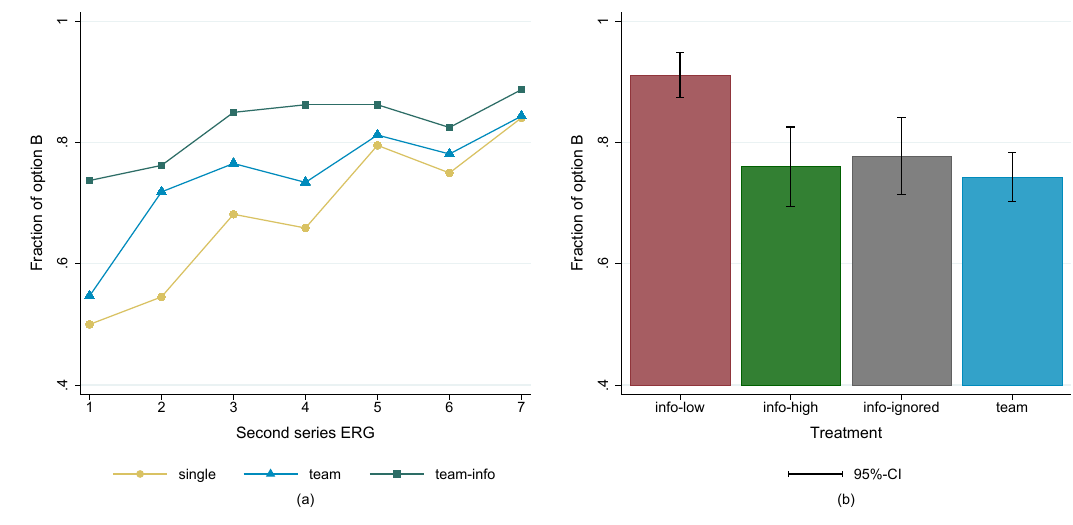
Figure 1. The proportion of B-choices in the 2nd series ( a ) for each game by treatment and ( b ) pooled by information (with